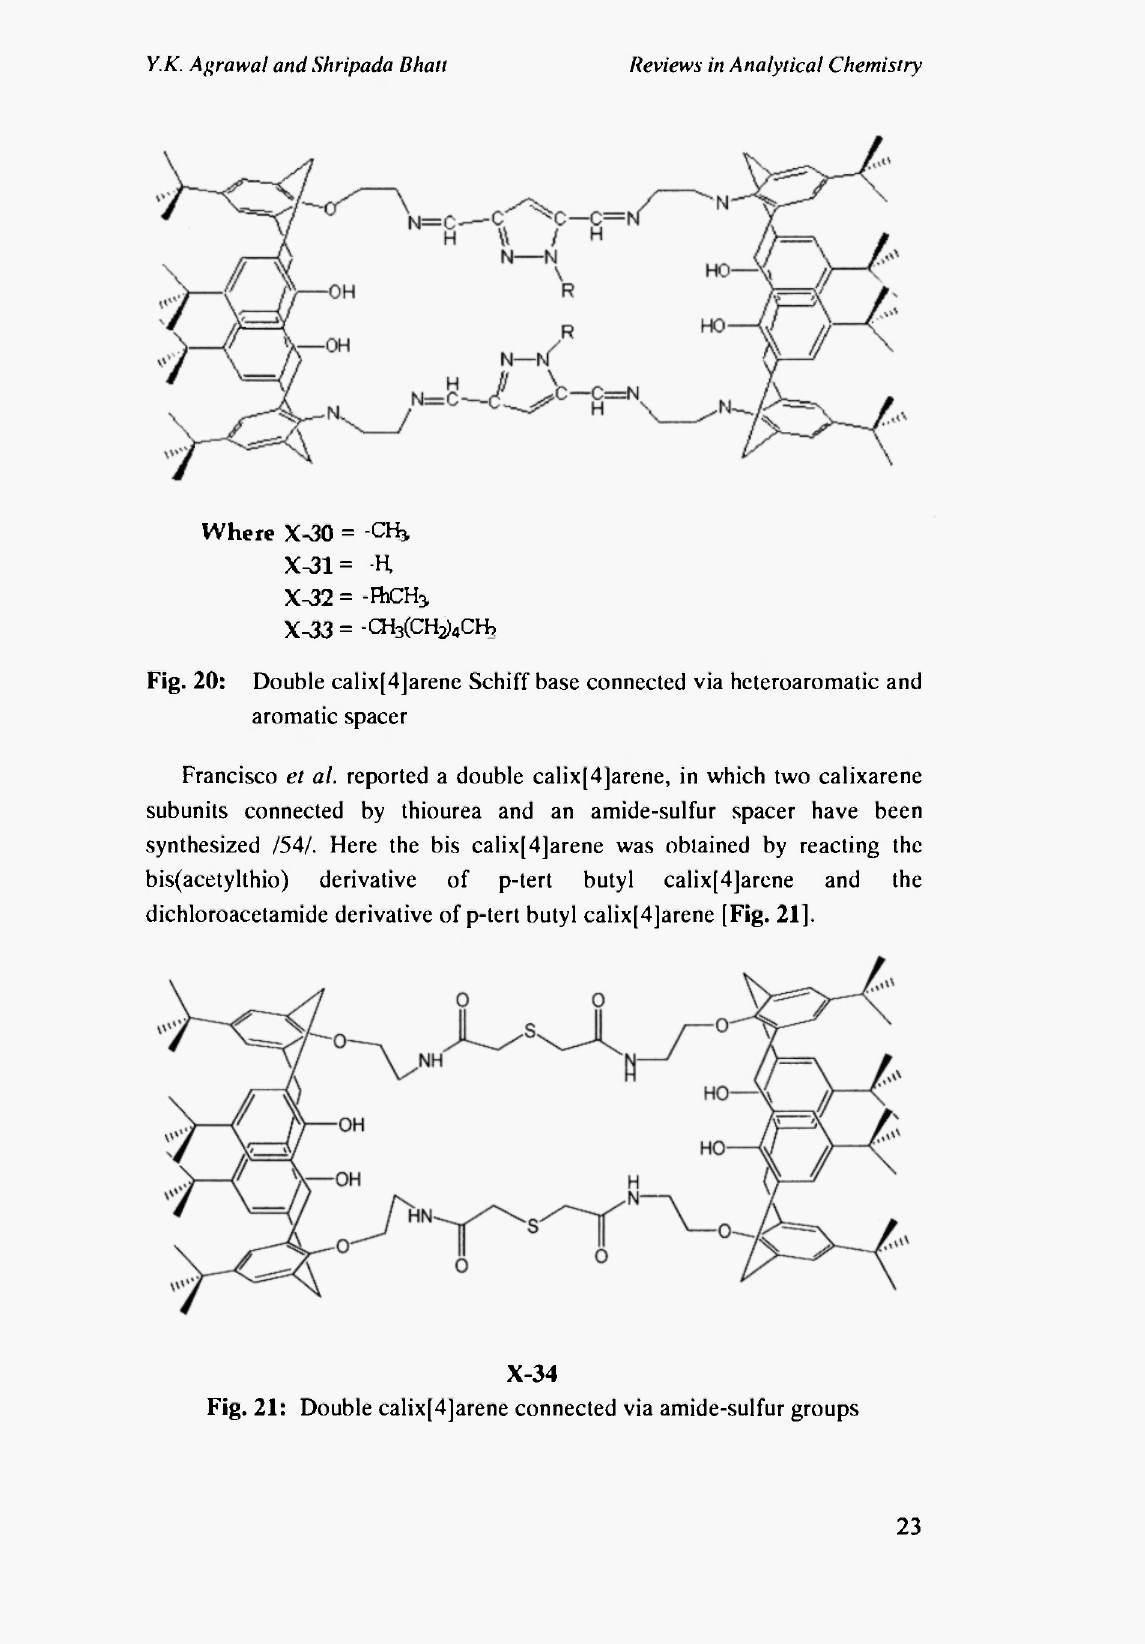
Fig. 21: Double calix[4]arene connected via amide-sulfur